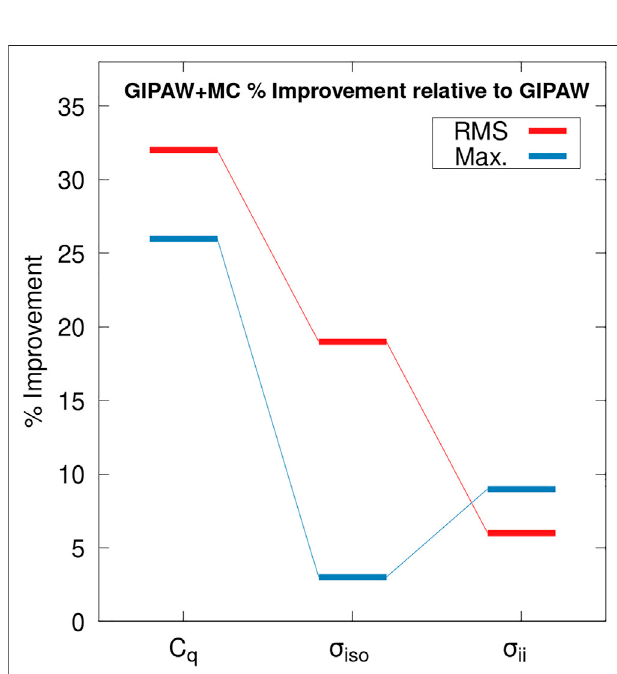
Frontiers in Chemistry |